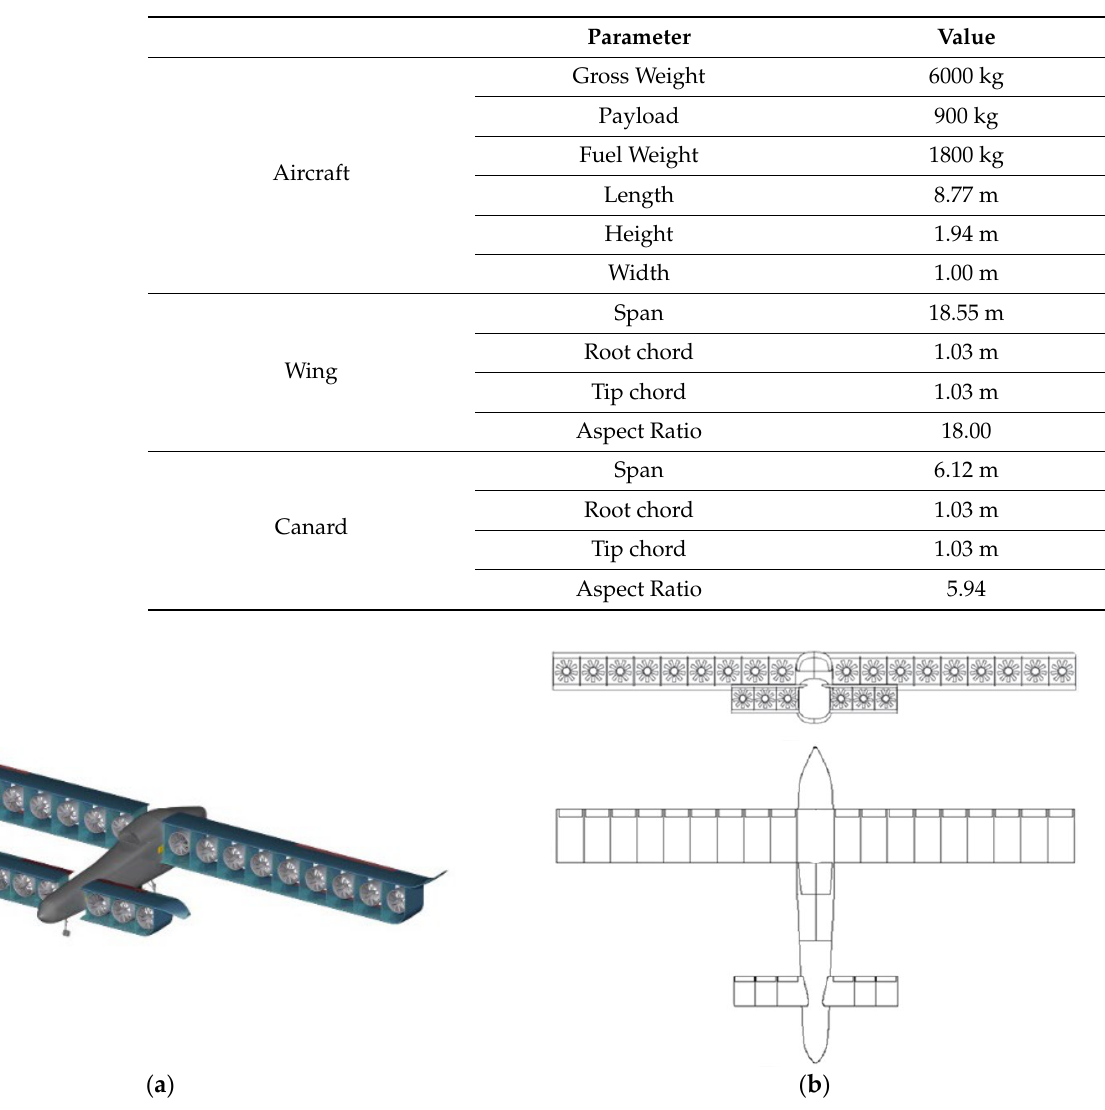
Table 10. Salient parameters of the conceptual design.